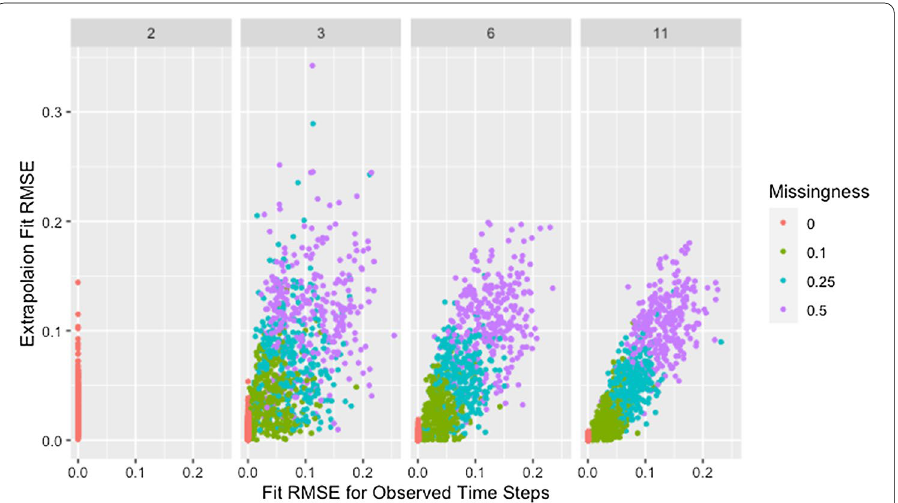
Fig. 12 Extrapolation RMSE by fit RMSE, missingness, and time steps. RMSE for observed and predicted opinions on extrapolated time steps by RMSE for observed and predicted opinions on observed time steps, proportion of missing data, and number of time steps across